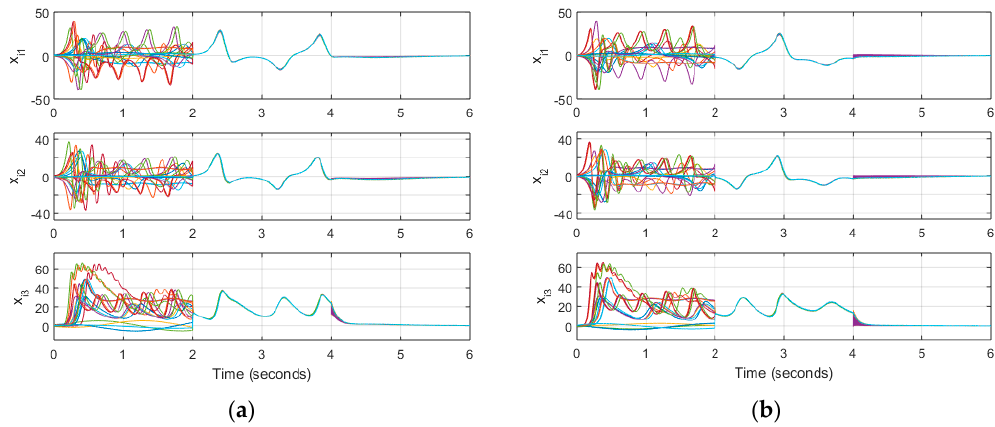
Figure 10. Complex network node dynamics when there are two controlled nodes, there is no noise in the system and: ( a ) Control input is applied every 5T with control gains d 3 = d 4 = 700; ( b ) Control input is applied every 10T with control gains d 3 = d 4 = 1200.